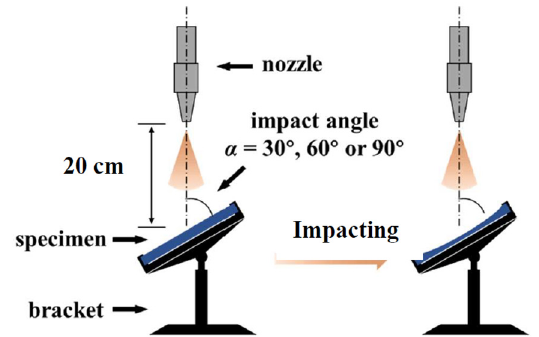
Figure 3. Location of the glass sample.